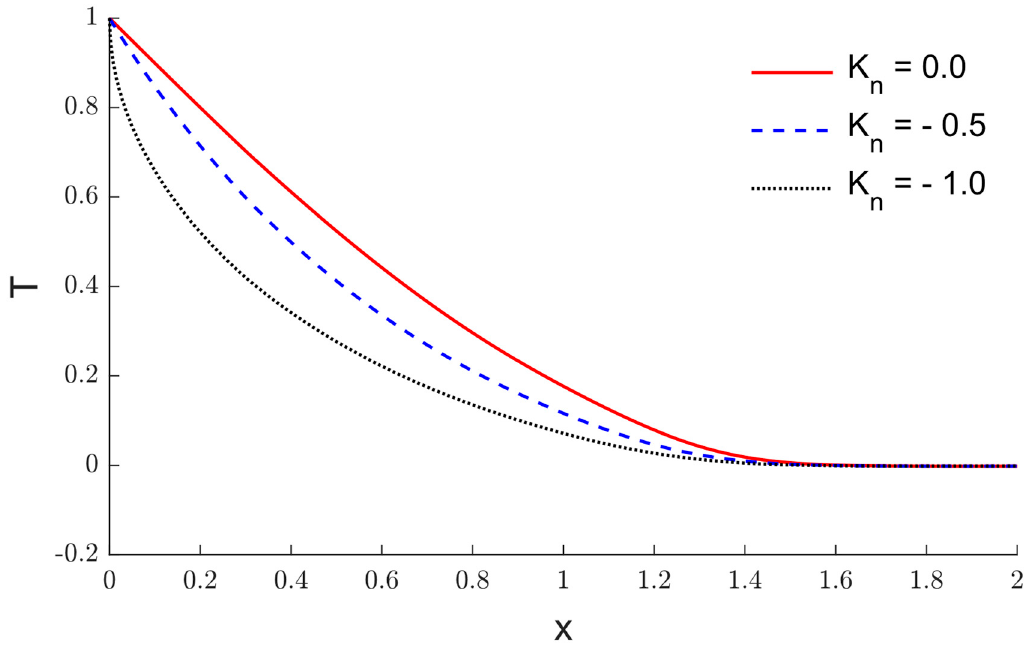
Figure 1. The impact of variable thermal conductivity and diffusivity in the temperature. variation T via the distance x when τ o = τ 1 =